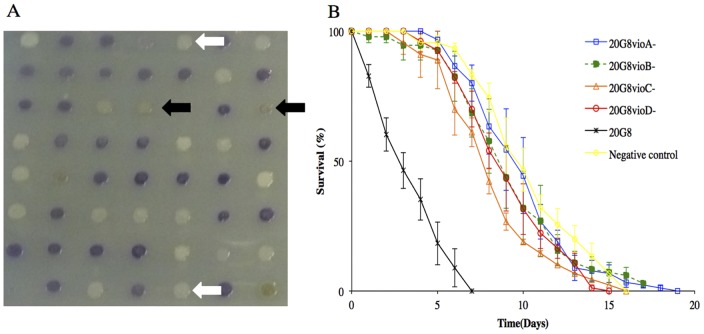
Characterization of the transposon mutant library of violacein producing clone 20G8.(A) Several mutants exhibit changes in violet pigmentation typical of the presence of violacein: 20G8vioA
− and 20G8vioB
− mutants have lost pigmentation (white arrows). 20G8vioC− and 20G8vioD− mutants express green-grey pigmentation (black arrows). (B) Nematode killing assay (N2 animals vs bacterial strains 20G8 clone and 20G8vioABCD
− mutants). Survival kinetics of nematodes fed with either the 20G8 clone or the 20G8vioABCD
− mutants deficient in violacein production. The killing phenotype of the four mutant clones is significantly reduced (p<0.0001) when compared to the wild type clone 20G8. A randomly chosen clone from the library with no activity is used as a negative control. Each data point represents means ± the standard error of three replicate plates. p values were calculated on the pooled data of all of the plates in each experiment by using the log-rank (Mantel–Cox) method.